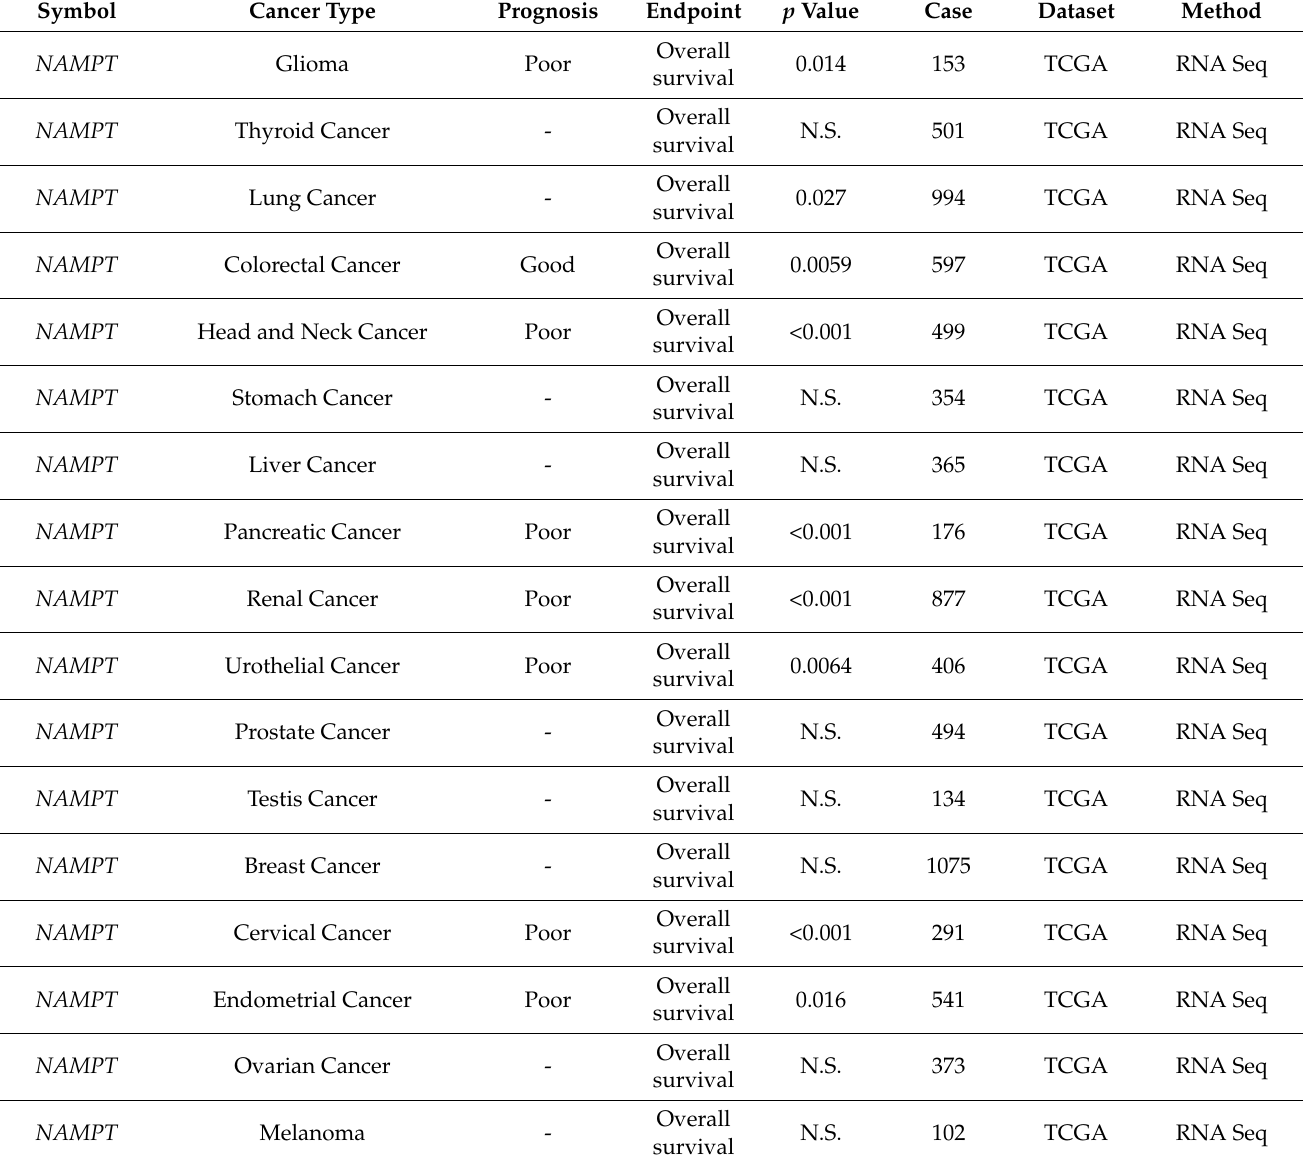
Table 2. Correlation of NAMPT with cancer patient